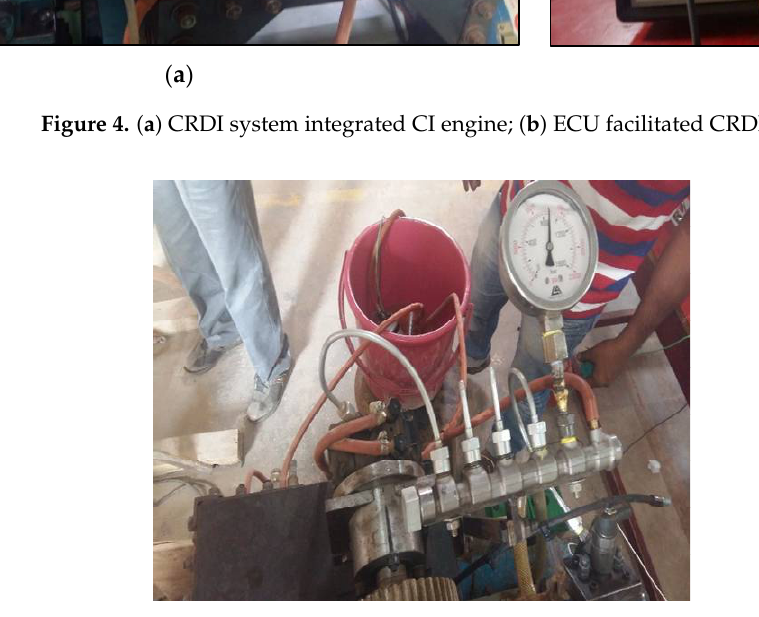
Figure 5. Pressure gauge for recording fuel IOP [42].